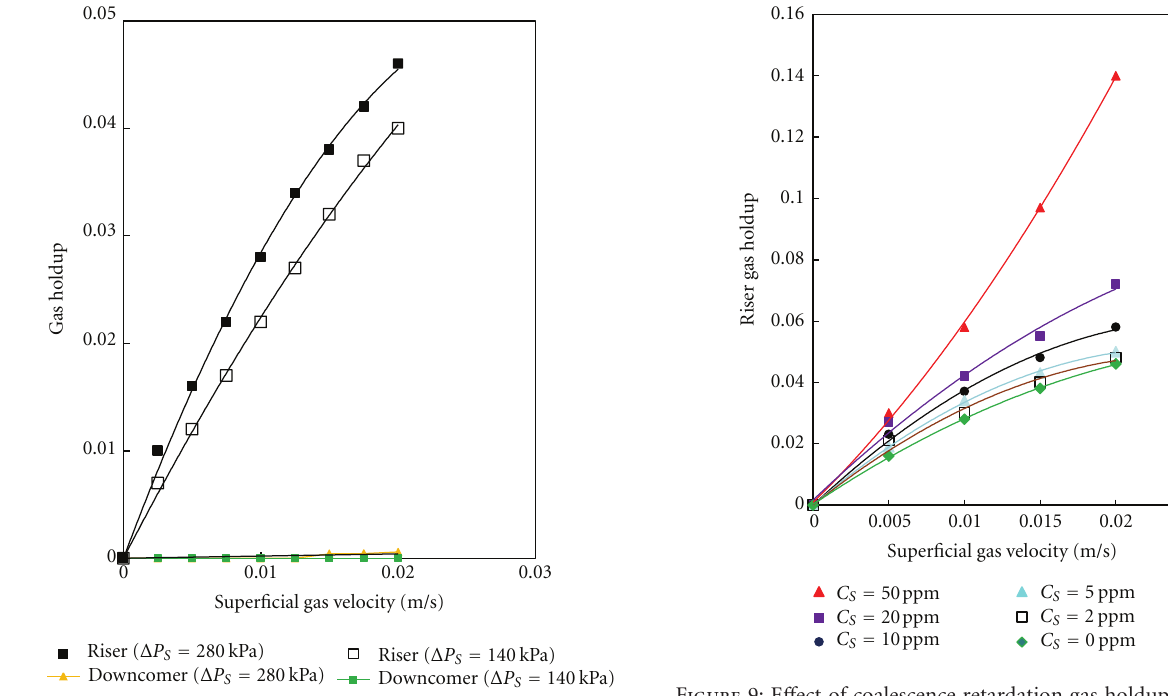
Figure 7: E ff ect of superficial gas velocity on the riser gas holdup for a rapidly coalescent system ( C S = 0 ppm).